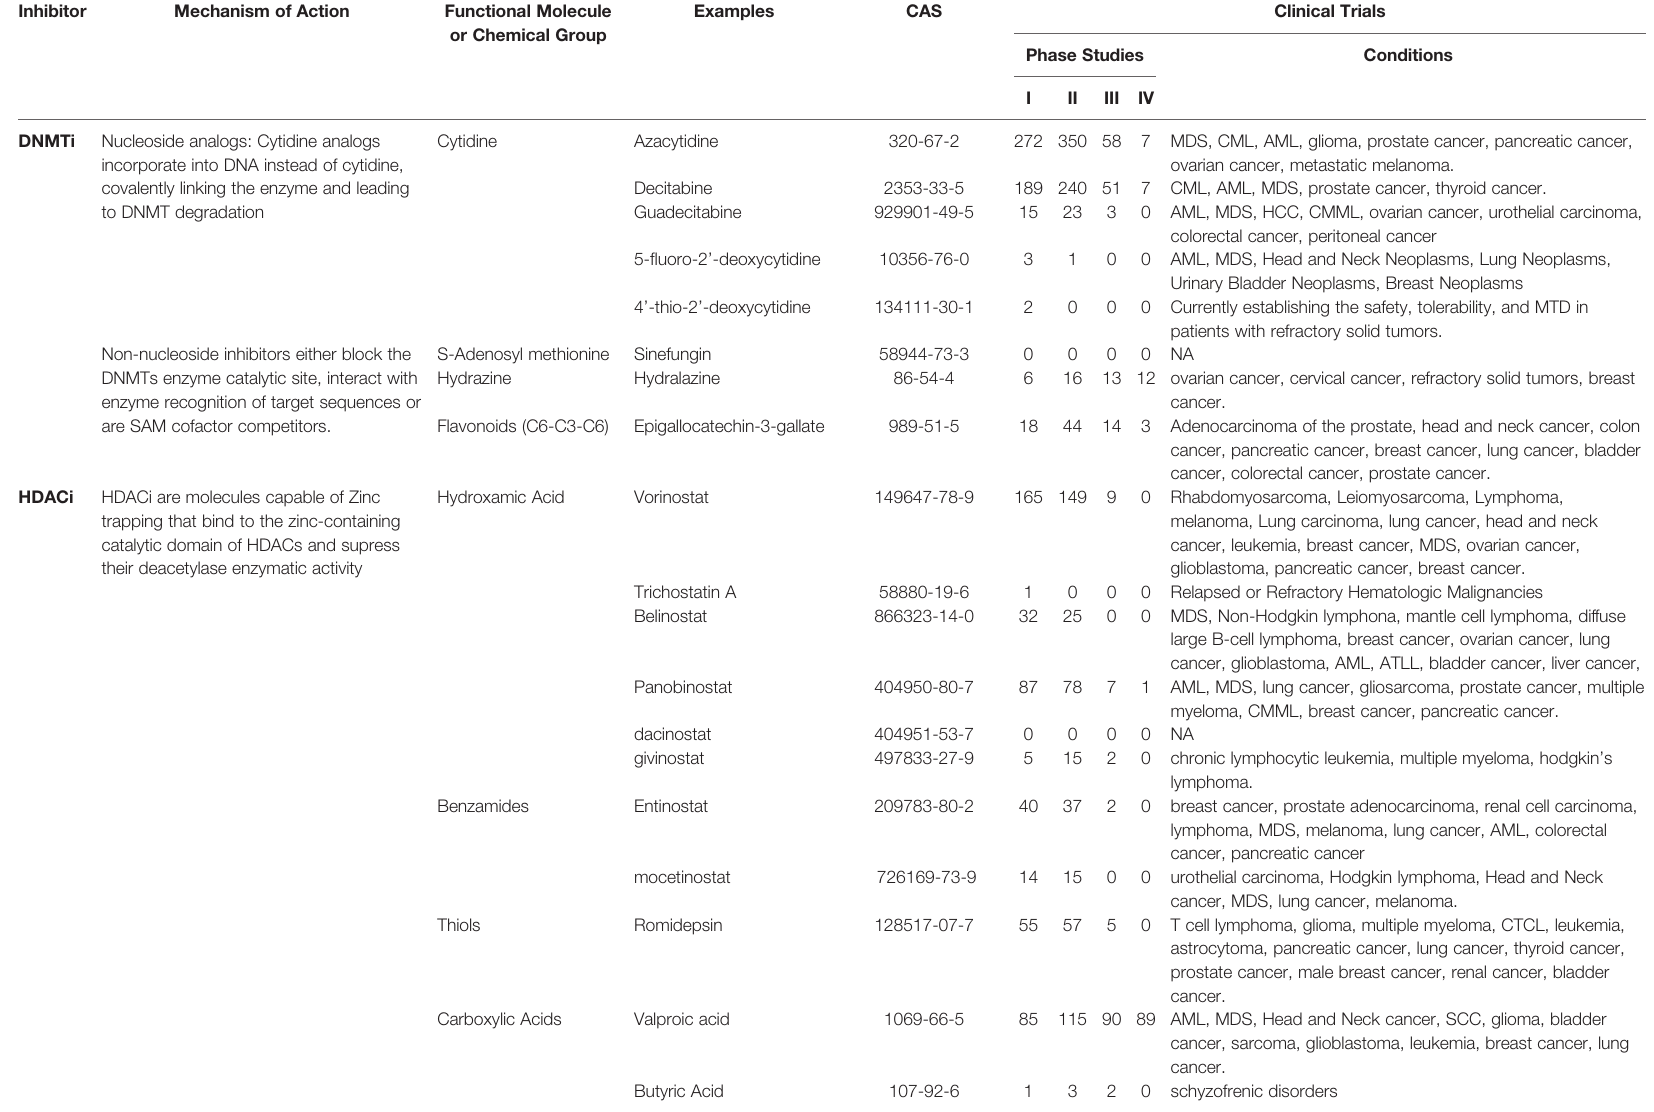
TABLE 2 | Overview of epigenetic inhibitors currently in clinical trials for cancer therapies.